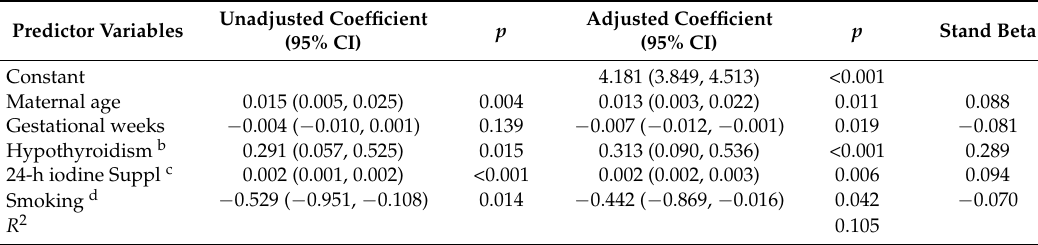
Table 4. Predictors of urinary iodine concentration (UIC) in pregnant women in Oslo ( n = 777), with UIC a (µg/L) as dependent variable.